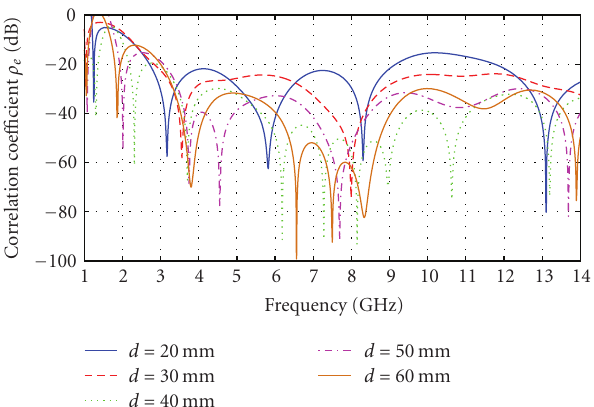
Figure 6: Simulated correlation coe ffi cient ρ e results of two- element UWB array.